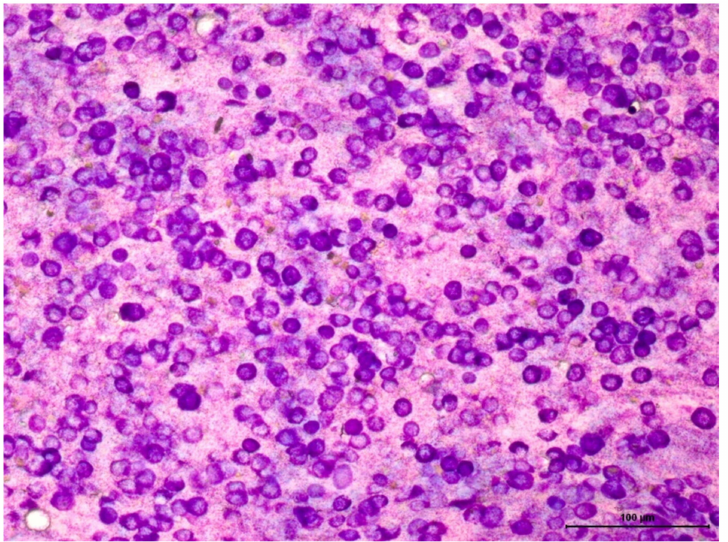
Figure 2. Cytological analysis of a cutaneous well-differentiated mast cell tumor stained with Giemsa. It is observed a round ell population, showing a high degree of cytoplasmic granulation. Granules are also observed in the slide background. Objective: 40 ×